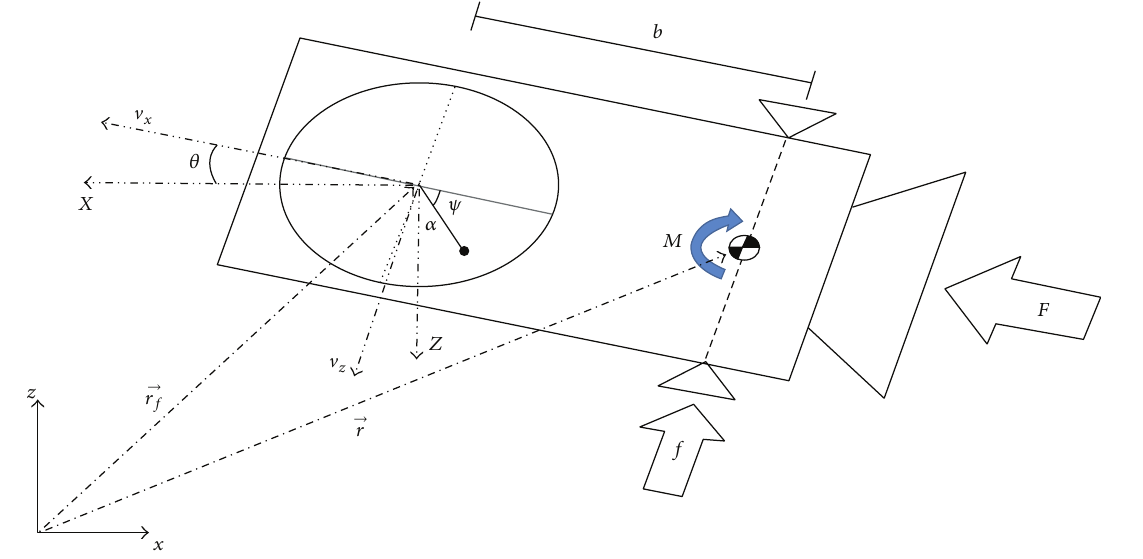
Figure 1: Satellite model with slosh dynamics pendulum analogous mechanical